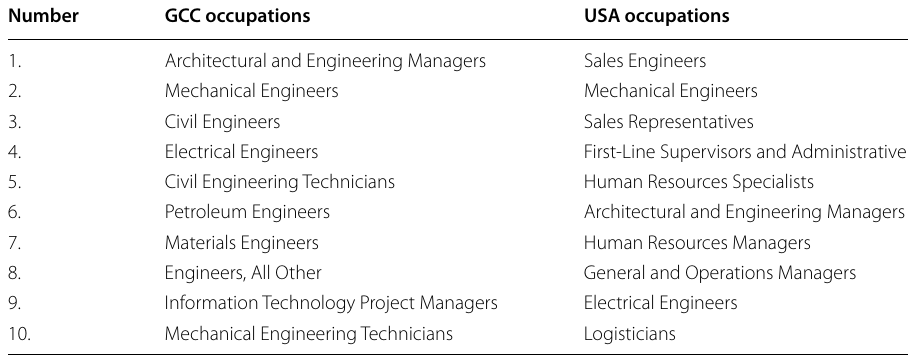
Table 3 Top 10 GCC (left) and USA (right) oil & gas occupations (LSI